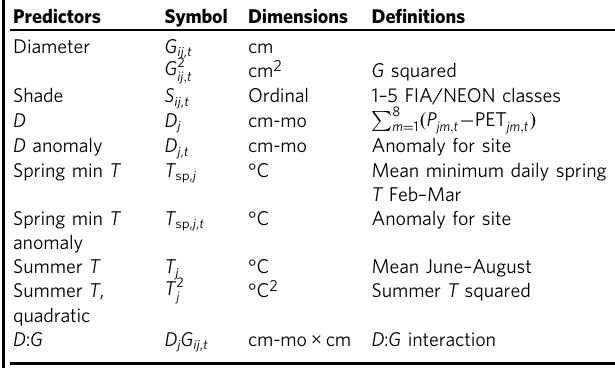
Table 1 Predictors in the model, not all of which are important for all